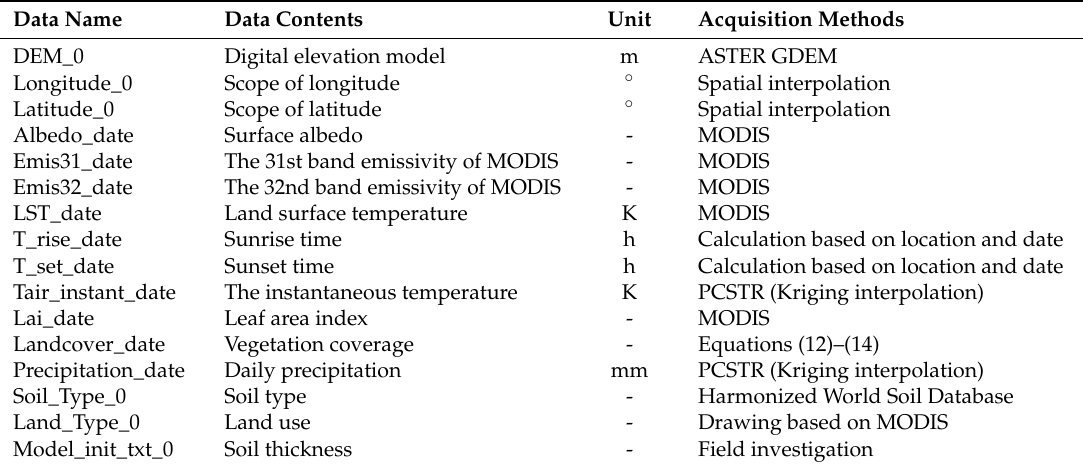
Table 1. Initial input data of the SVAT